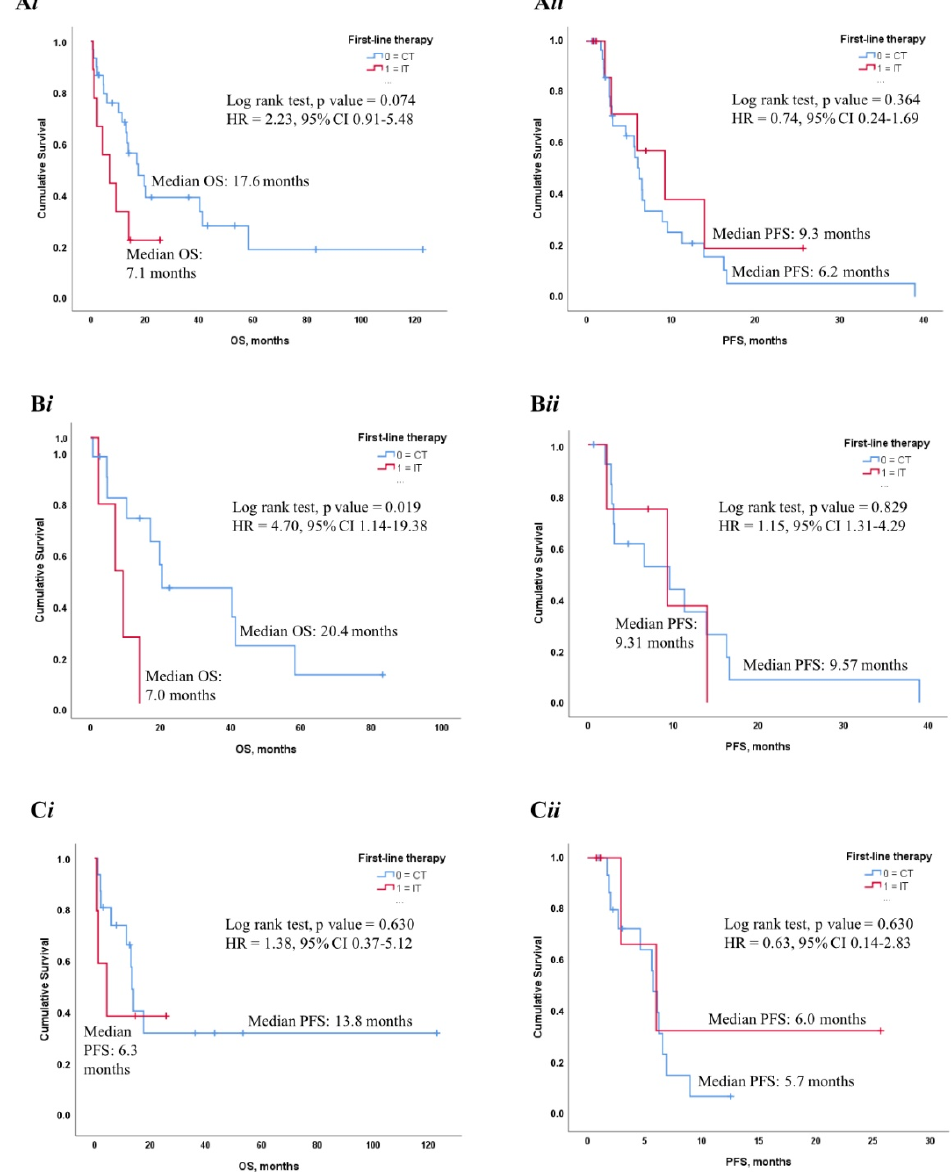
Figure 3. ( A i , A ii ): Kaplan Meier survival curves reporting the impact of first-line treatment (CT vs. IT) on OS and PFS in the overall population. ( B i , B ii ): Kaplan Meier survival curves reporting the impact of first-line treatment (CT vs. IT) on OS and PFS in the BRAF V600E group. ( C i , C ii ): Kaplan Meier survival curves reporting the impact of first-line treatment (CT vs. IT) on OS and PFS in BRAF non-V600E group. Abbreviations: CT, chemotherapy; IT,